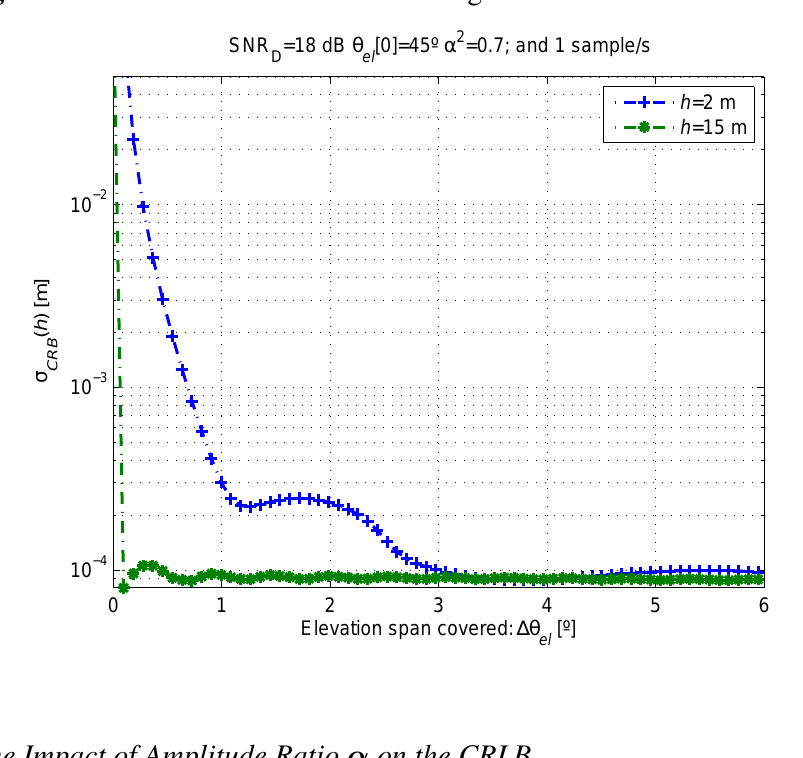
Figure 6. CRLB for different elevation angle variations and receiver